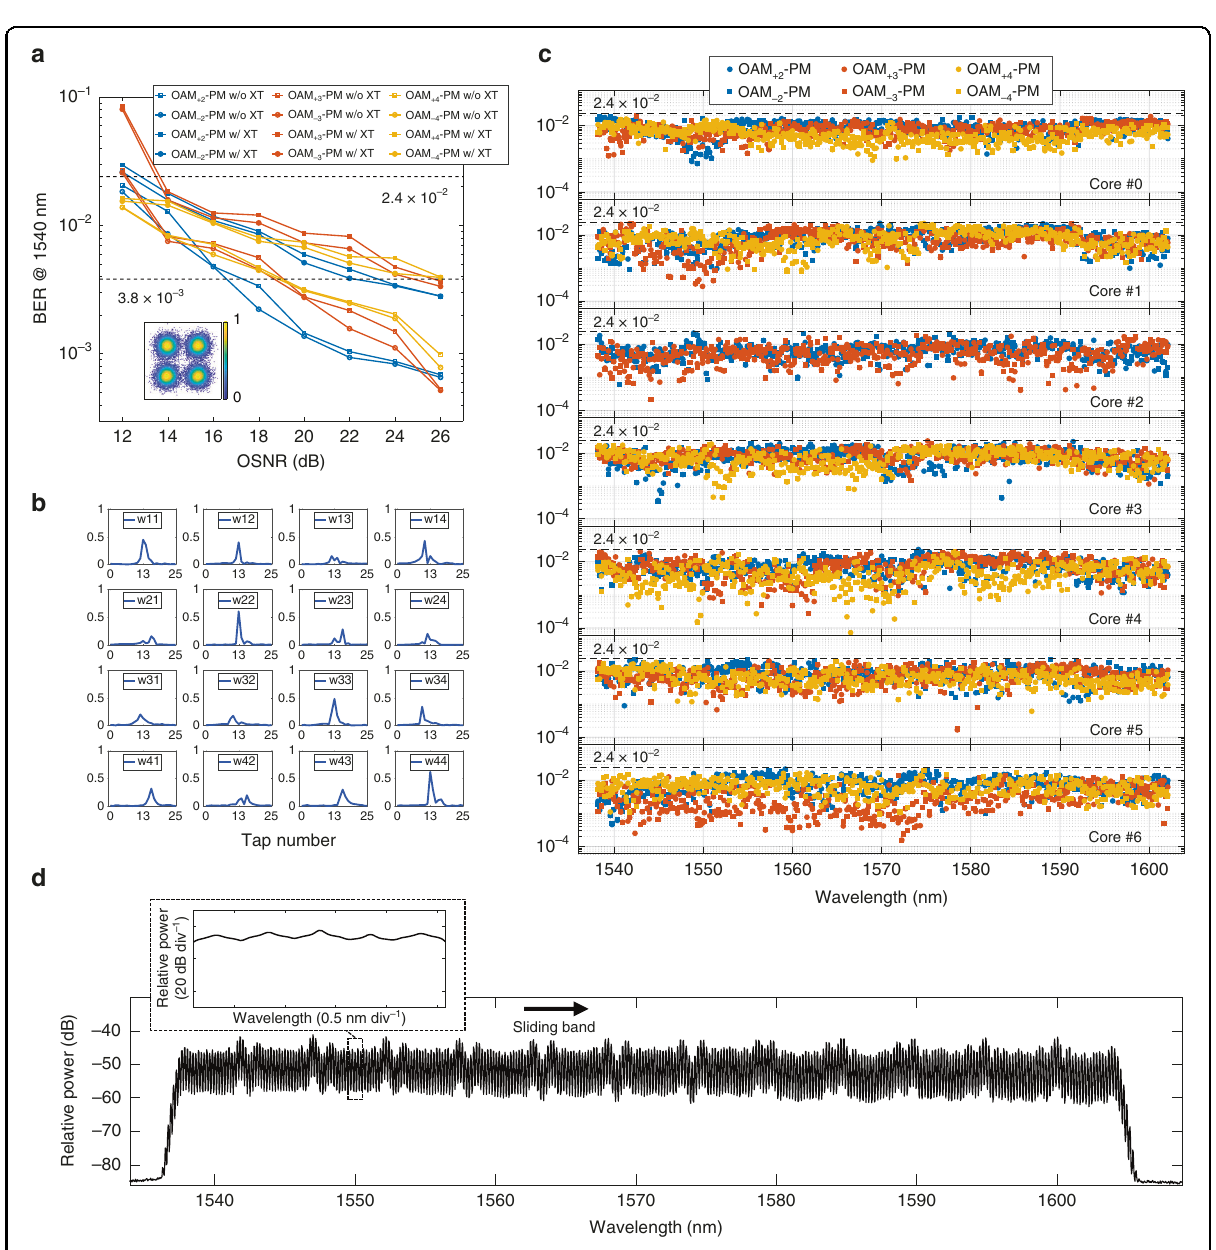
Fig. 6 The characterization of the communication system. a The measured BER vs. OSNR curves at 1540 nm; b The absolute values of tap weights in 16 FIR fi lters of 4 × 4 MIMO equalizers to equalize the four modes belonging to OAM MGs |l | = 3 at 1540 nm; c The measured BERs of all 24960 channels after 34 km OAM-SDM-WDM transmission; d An optical spectrum of WDM signals with 312 wavelengths, inset: sliding test channel